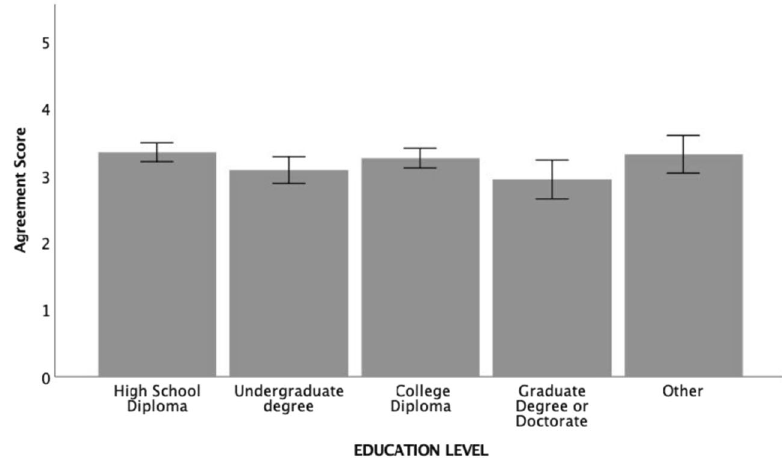
Fig. 4 Consumer acceptance to pay government tax by education level. Error bars indicate standard deviation.